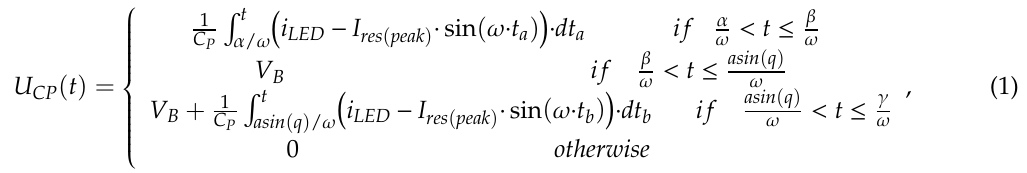
Figure 3. Detailed circuit waveforms and angle definitions.